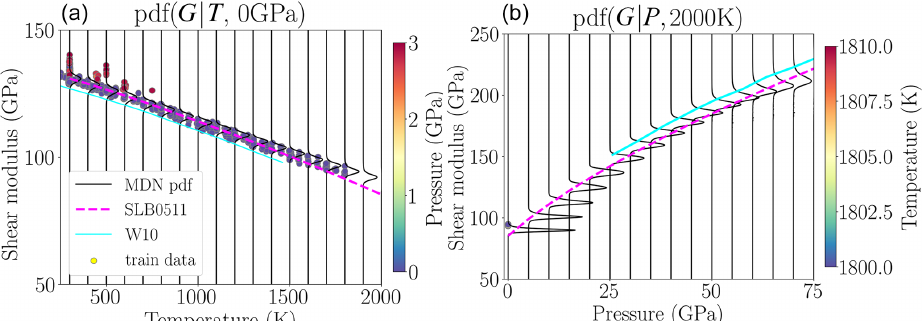
Figure 4. Probability density functions for the shear modulus of MgO along a 0 GPa isobar (a) and a 2000K isotherm (b) compared with Stixrude and Lithgow-Bertelloni (2005, 2011) and Wentzcovitch et al. (2010b). While the former study closely follows the maximum likelihood predicted by neural networks along the isobar, the latter study falls outside the experimental uncertainty range. The predictions from W10 are shown only for pressures and temperatures where the quasiharmonic approximation is valid (Wentzcovitch et al., 2010a). Circles represent a sub-set of the total data whose pressure (or temperature) falls within the range shown in the colour bar on the side panel. Along the 2000K isotherm, the neural network predictions go beyond the range of the experimental data at high pressure, as reflected in the widening of pdf’s when the pressure